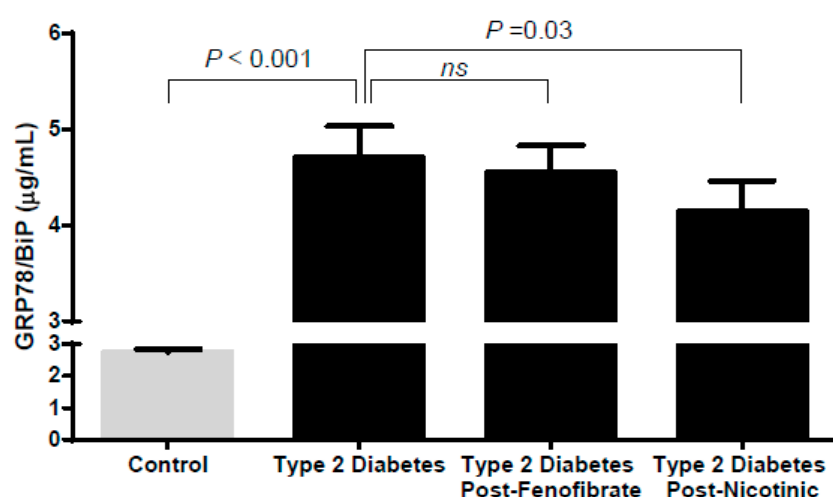
Figure 3. Circulating 78 kDa glucose-regulated protein / binding immunoglobulin protein (GRP78 / BiP) in the control group and the type 2 diabetes patients before and after fenofibrate and nicotinic treatment in a validation cohort. The results are expressed as the mean ± SEM. p values for the group comparisons are reported for the age- and gender-adjusted ANCOVA test or paired Wilcoxon test.